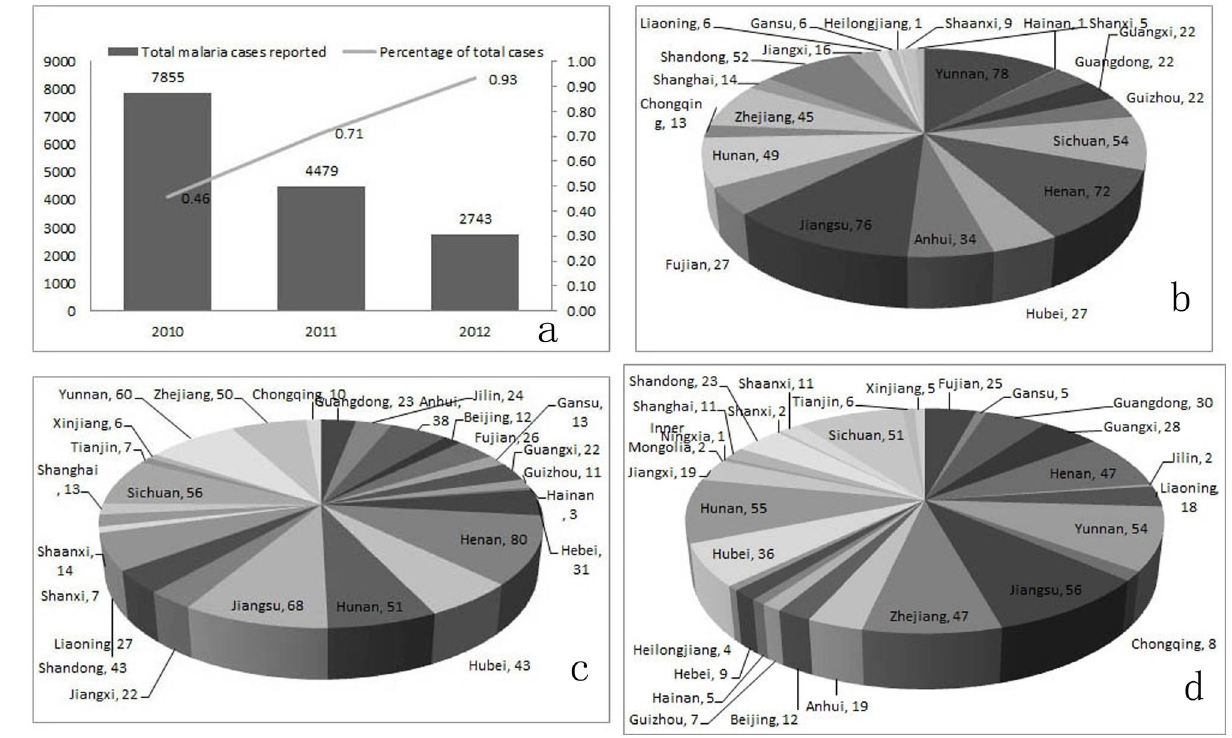
Figure 4. The Changing Distribution of Imported Malaria Cases Reported, 2010-2012. a: imported malaria in the mainland of China, 2010-2012; b-d: national distribution of imported malaria at county level in 2010, 2011 and 2012, respectively. doi: